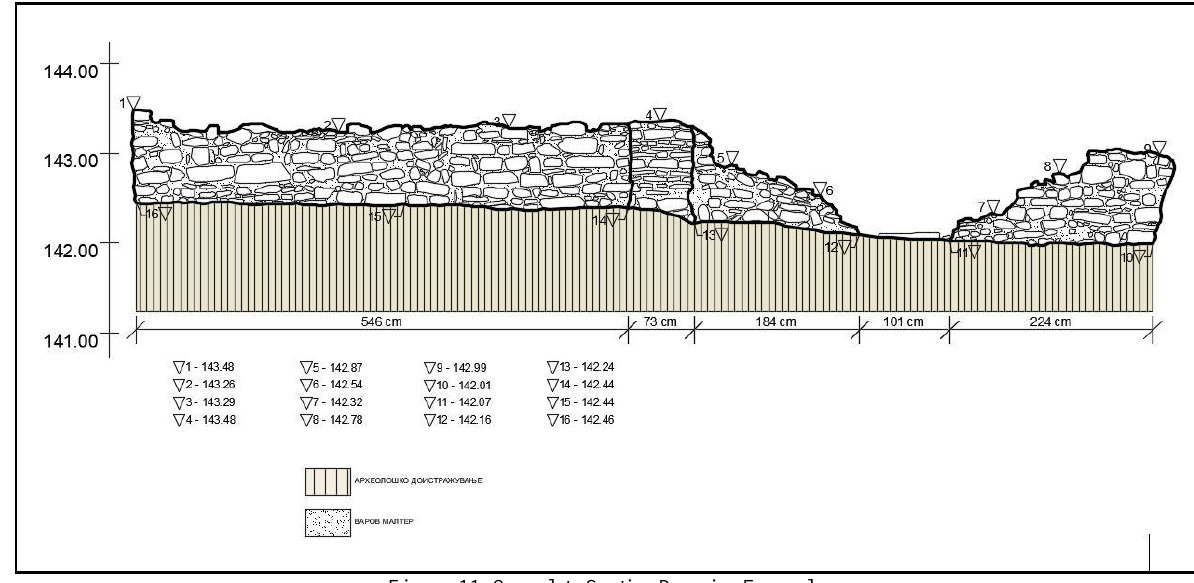
Figure. 11. Complete Section Drawing Example